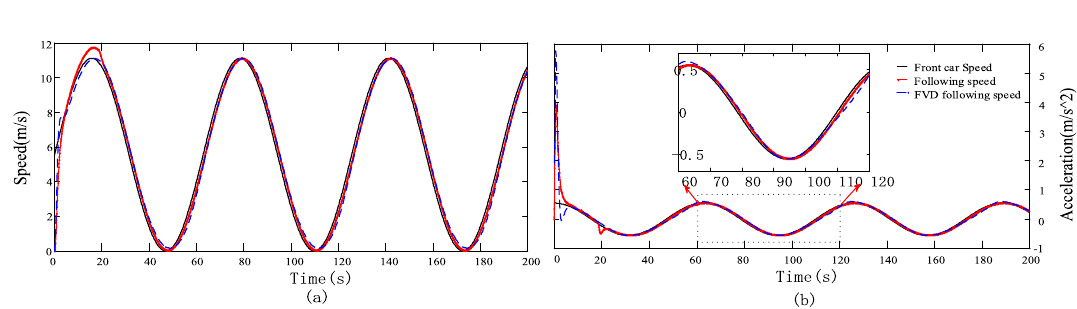
Figure 5. ( a ) Simulation results of the following speed curve for Case 1. ( b ) Simulation results of the following acceleration curve for Case 1.